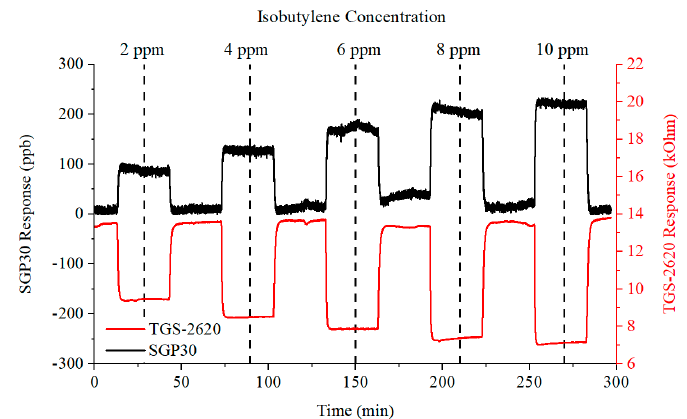
Figure 9. SGP30 and TGS-2620 gas sensor responses to increasing concentrations of isobutylene.